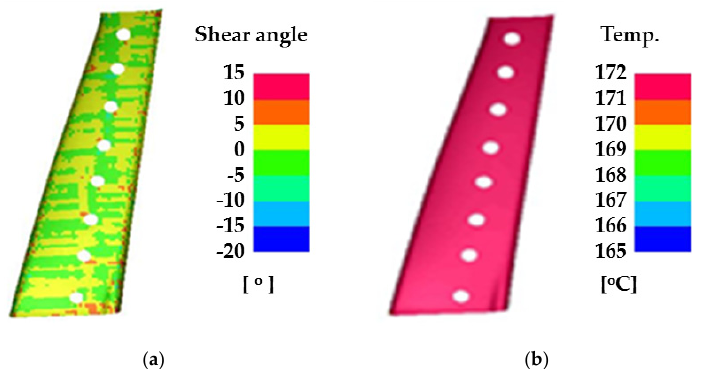
Figure 7. Results of FE simulation for forming process of CFRTP: ( a ) shear angle distribution and ( b ) temperature distribution.